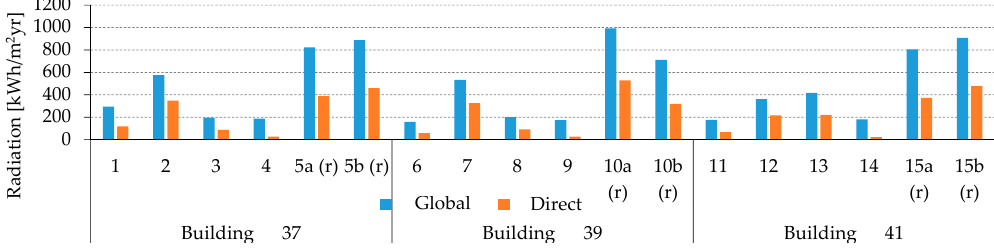
Figure 21. Average irradiation on the roofs (r) and façades in the critical area for feasibility study I.